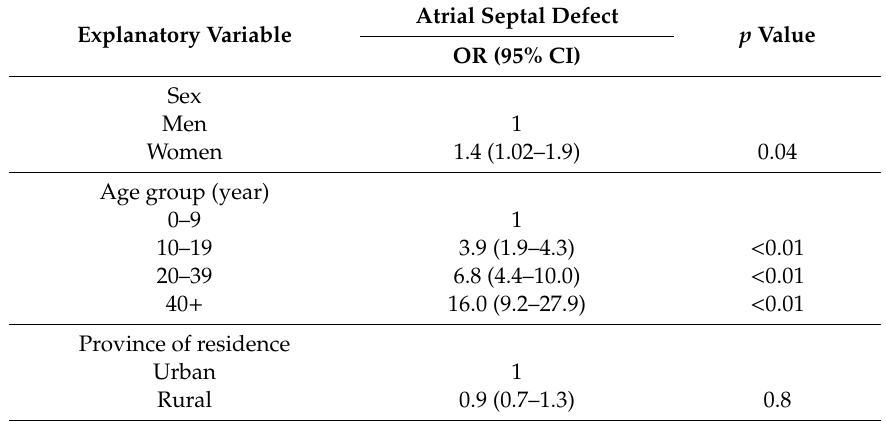
Table3. Factorsassociatedwithatrialseptaldefect, 2010–2015: multivariablelogisticregressionanalysis. Atrial Septal Explanatory Variable